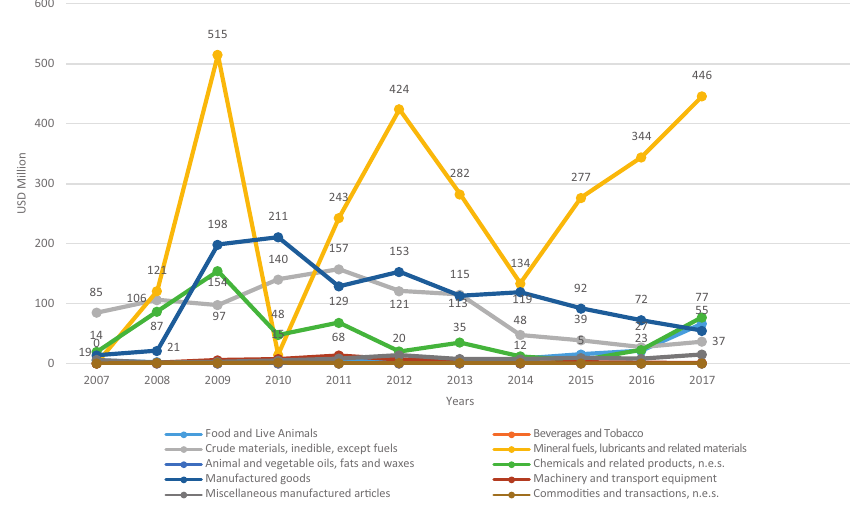
Figure 2. Egypt exports to